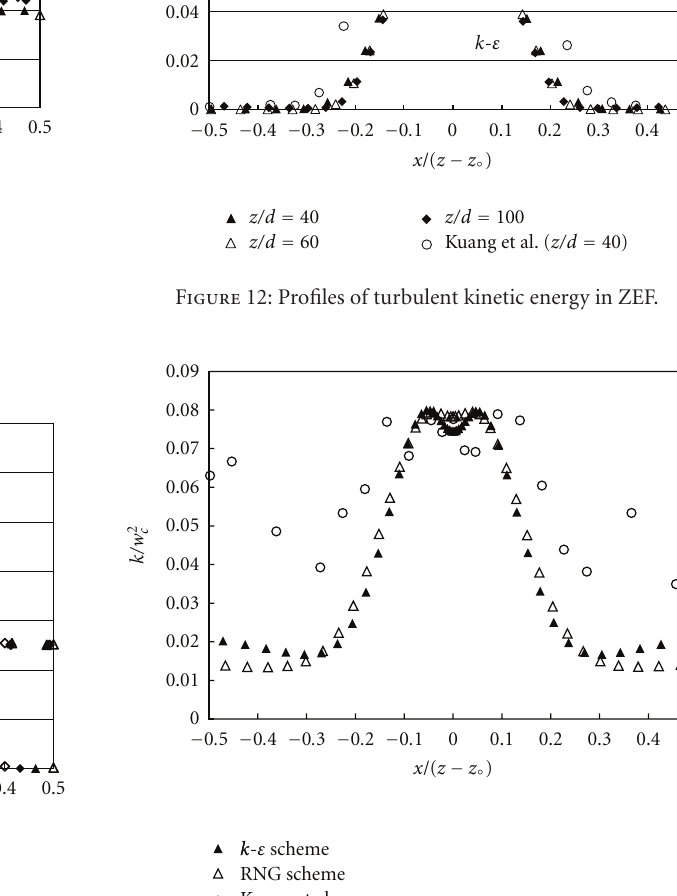
the k - ε scheme compares well with the measured data in the center part of the jet ( − 0 . 1 ≤ x/ ( z − z ◦ ) ≤ 0 . 1), and the TKE is underpredicted outside of this zone. The TKE profiles predicted by the RNG scheme do not show similarity. The TKE is overpredicted near the center of the jet for low values of z/d . This may be the result of higher sensitivity of the TKE production on the velocity gradients in the case of the RNG scheme. In the zone of surface impingement, as shown in Figure 13 for z/d = 110, the TKE predicted by both schemes agrees well with the measured data near the center of the jet; however, the values are underpredicted in the outer part of the jet. The variations of lateral velocity in the zone of horizontal jets (ZHJ) predicted by the k - ε and RNG schemes are